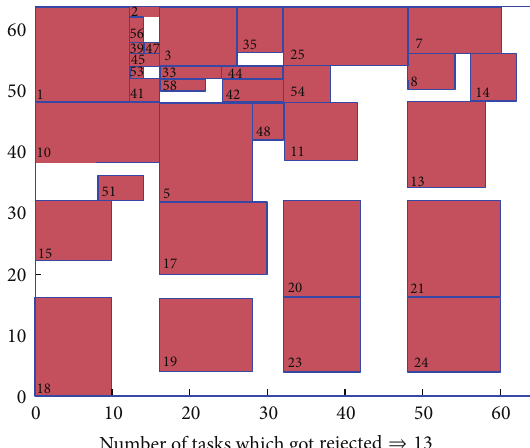
Figure 5: Rejection ratio for different values of load.